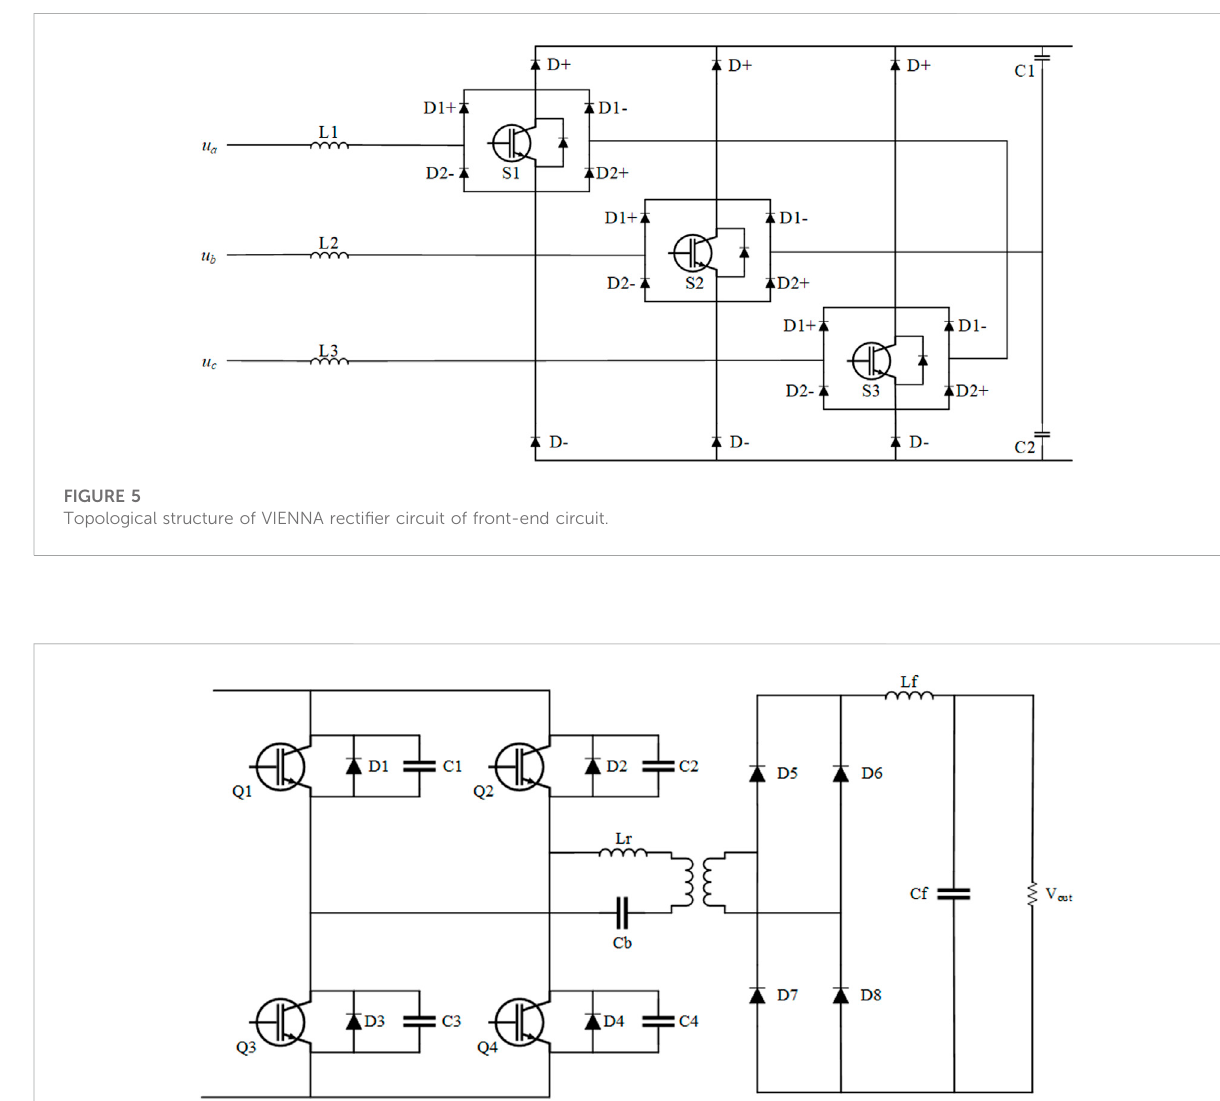
FIGURE 6 The circuit topology structure of the phase-shifted full-bridge converter of the back-stage